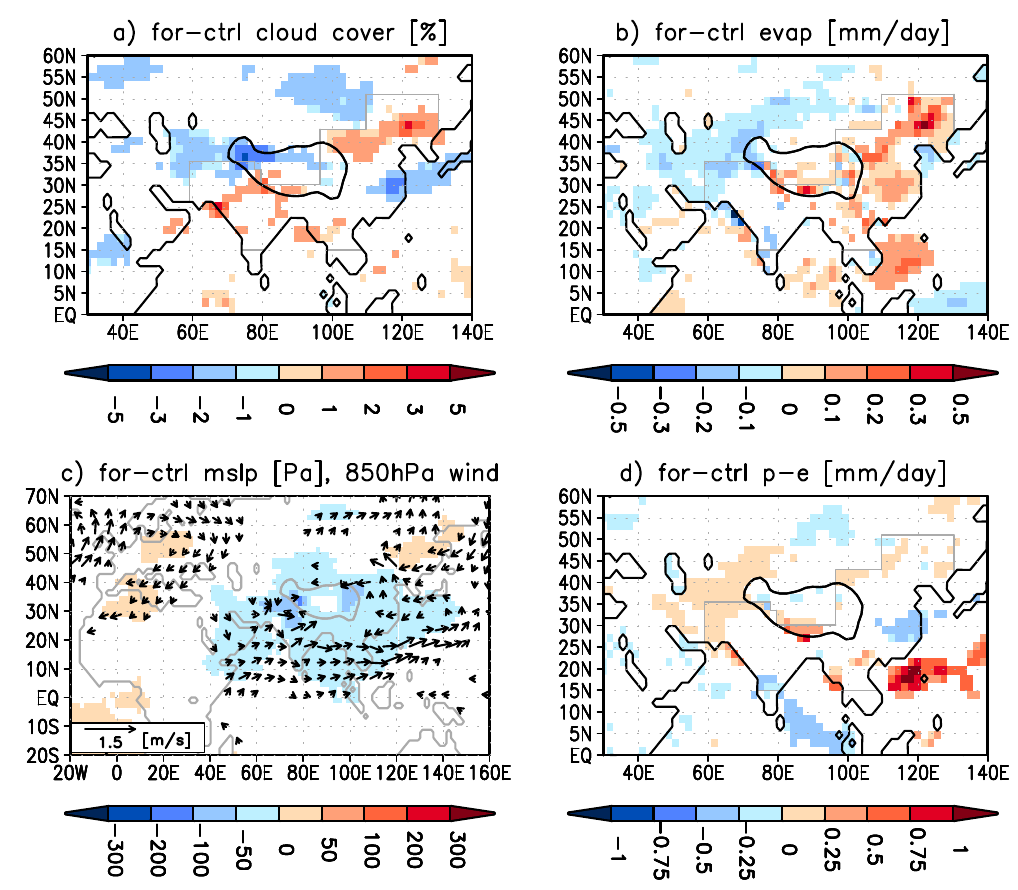
Fig. 5. Simulated change of different parameters influencing the precipitation change between the afforestation experiment (for) and the control run (ctrl), averaged over the monsoon season. (a) total cloud cover in %; (b) evaporation in mmday − 1 ; (c) mean sea level pressure in Pa, shaded, combined with 850hPa wind in ms − 1 , vector; (d) precipitation-evaporation in mmday − 1 as approximation of the moisture convergence. Except for the wind-field, only values exceeding the 95%-significance level in a standard student’s t-test are shown. Instead, wind-vectors are masked out when their magnitude is smaller than one-tenth of the maximum vector length (here: 0.15ms − 1